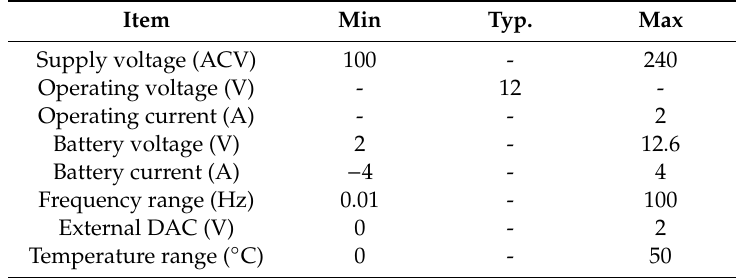
Table 1. Specification of the MTC (multi type chemistry charging /